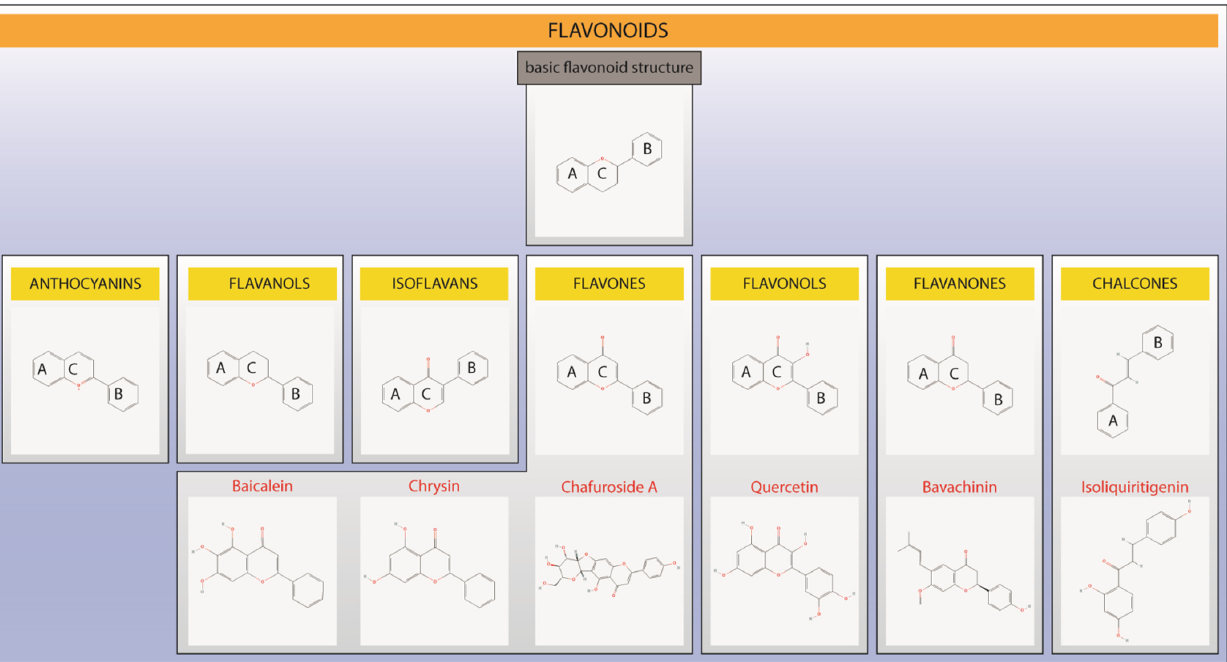
Figure 3. Basic structure of flavonoids, main classes, and examples (in red) of molecules from classes tested using nanotechnology in asthma models. Figure was designed in Adobe Illustrator 2023 (Adobe©, San Jose, CA, USA). Chemical structures were downloaded from PubChem (pubchem.ncbi.nlm.nih.gov).